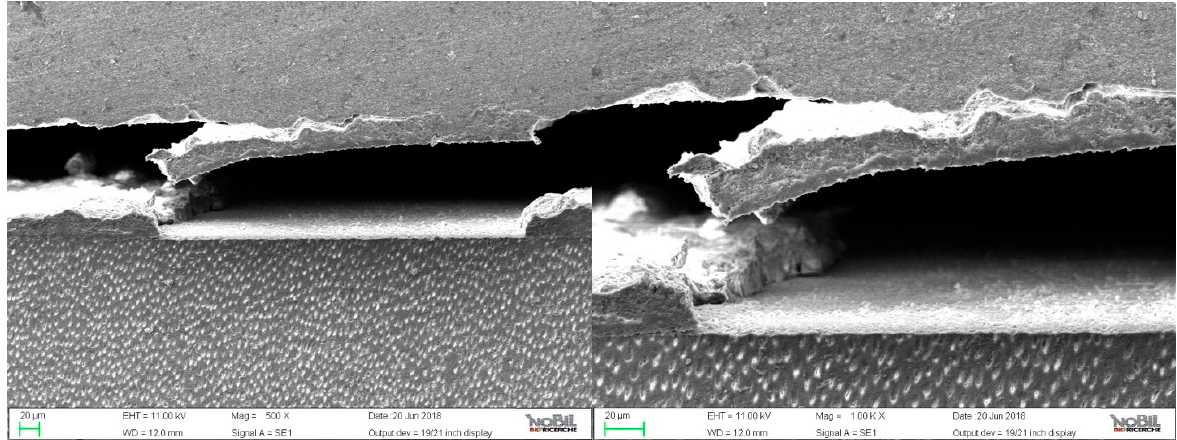
Figure 3. A mixed failure, observed in a specimen treated with Panavia V5 and stored in artificial saliva for 1 year.